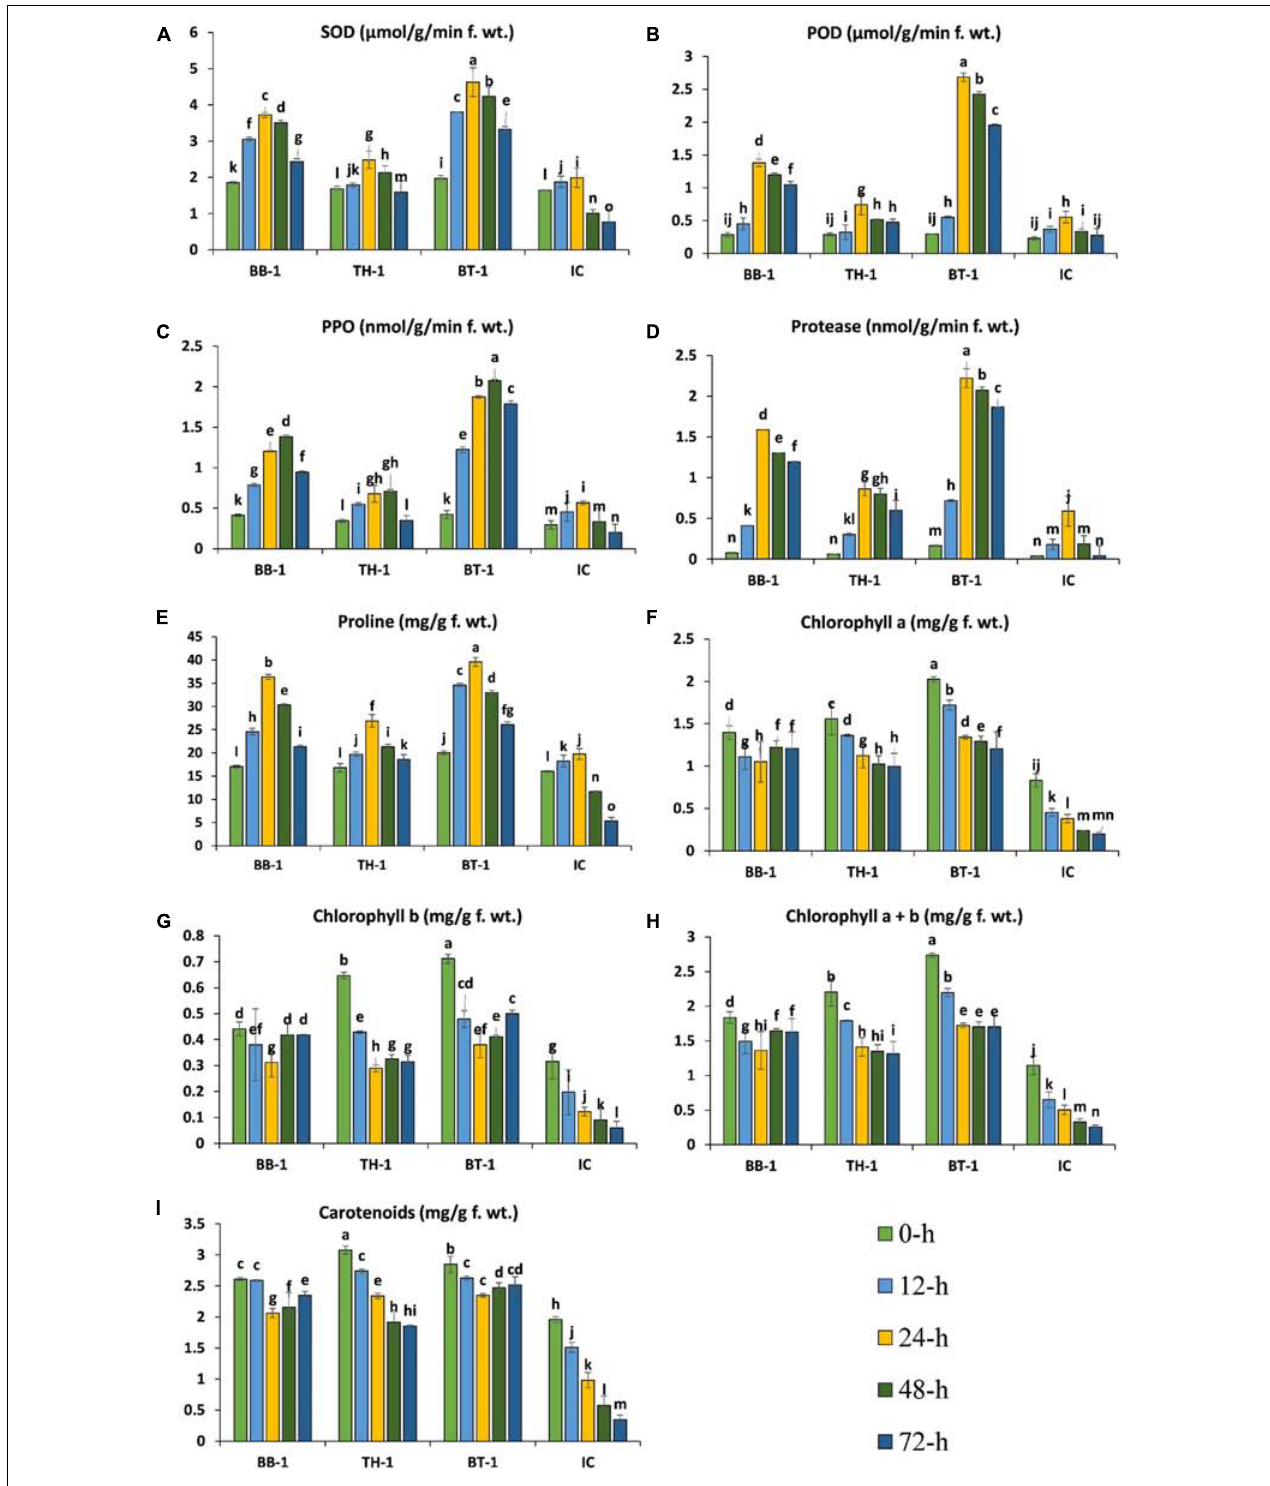
FIGURE 4 | Beauveria bassiana OFDH1-5 and T. asperellum GDFS1009 induced response of maize antioxidants and chlorophyll content under O. furnacalis attack. (A) Superoxide dismutase (SOD); (B) peroxidase (POD); (C) polyphenol oxidase (PPO); (D) protease; (E) proline; (F) chlorophyll a; (G) chlorophyll b; (H) chlorophyll a + b; (I) carotenoids. Different lowercase letters above each bar indicate significant differences among treatments ( p < 0.05). Treatments include (BB-1) seed treatment with B. bassiana OFDH1-5, (TH-1) seed treatment with T. asperellum GDFS1009, (BT-1) seed treatment with a consortium of B. bassiana OFDH1-5 and T. asperellum GDFS1009, (IC) no